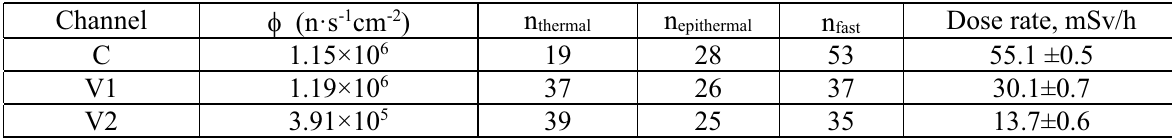
Table III. Calculated neutron flux and dose rate estimation for sample at the irradiation positions (h=0) at Central, Vertical I and Vertical II channels of the neutron storage